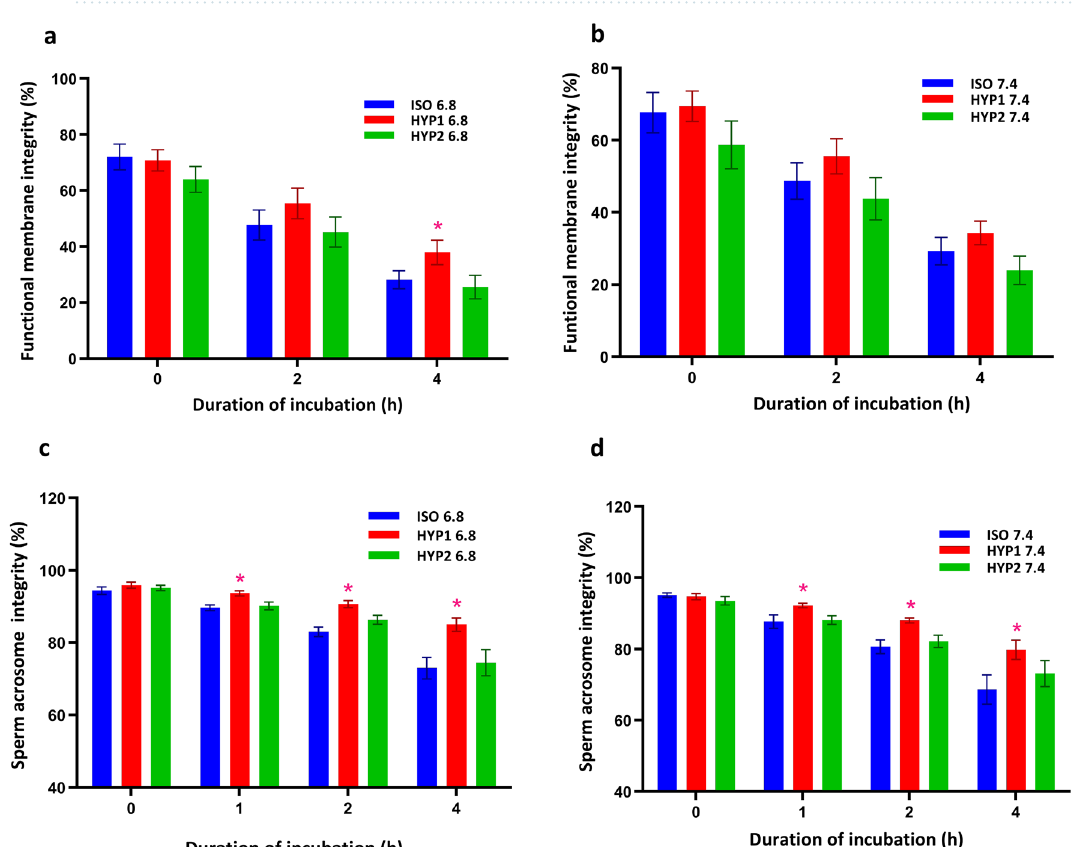
Figure 4. Effect of osmolality and pH on functional membrane integrity ( a , b ) and acrosome integrity ( c , d ) in bovine sperm incubated in vitro. The hyperosmotic (HYP1) uterine ( a ) environment significantly ( p < 0.05) protected the functional membrane integrity at 4 h of incubation as compared to isosmotic condition. The acrosome integrity was also maintained significantly higher in sperm incubated at 355 mOsm in both pH 6.8 and 7.4 from 1 h. The interaction between osmolality and incubation time was significant ( p < 0.05) for sperm acrosome integrity. *represent the effects of osmolality, differ significantly ( p < 0.05) at a particular time point. (ISO: 290 mOsm/kg; HYP1: 355 mOsm/kg; HYP2: 420 mOsm/kg; BI: Before